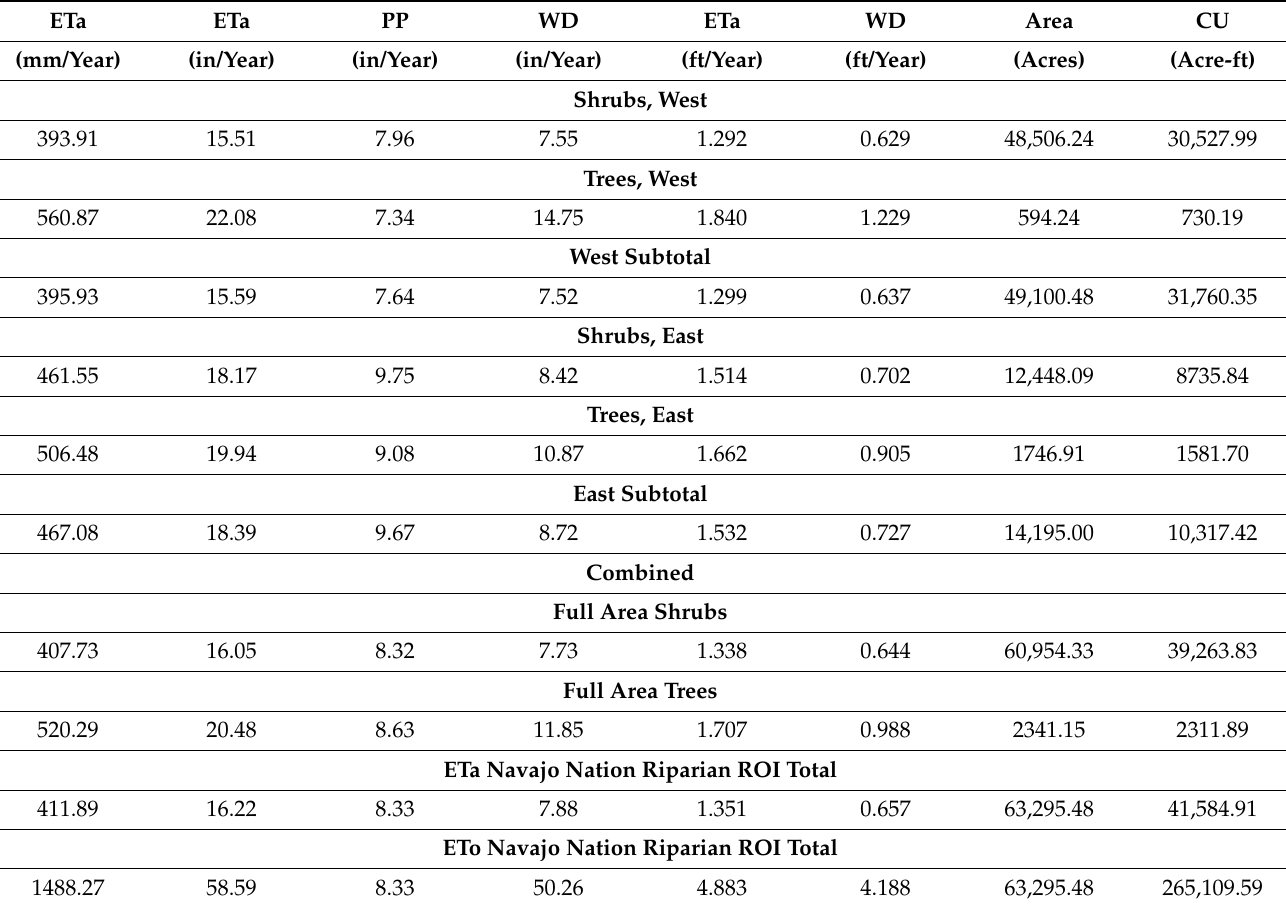
Table 9. Final water metric results for the riparian ROI showing the rasterized ‘ best-approximation ’ estimate of the mean data from 2014 to 2020 using gridded PRISM data (4 km) and Landsat (30-m) to derive ETa (mm, in, ft), PP (in), WD (in, ft) and ETo (mm, in, ft) (last row); the CU (acre-ft, last column) is calculated by ground area for shrubs, trees, and total riparian